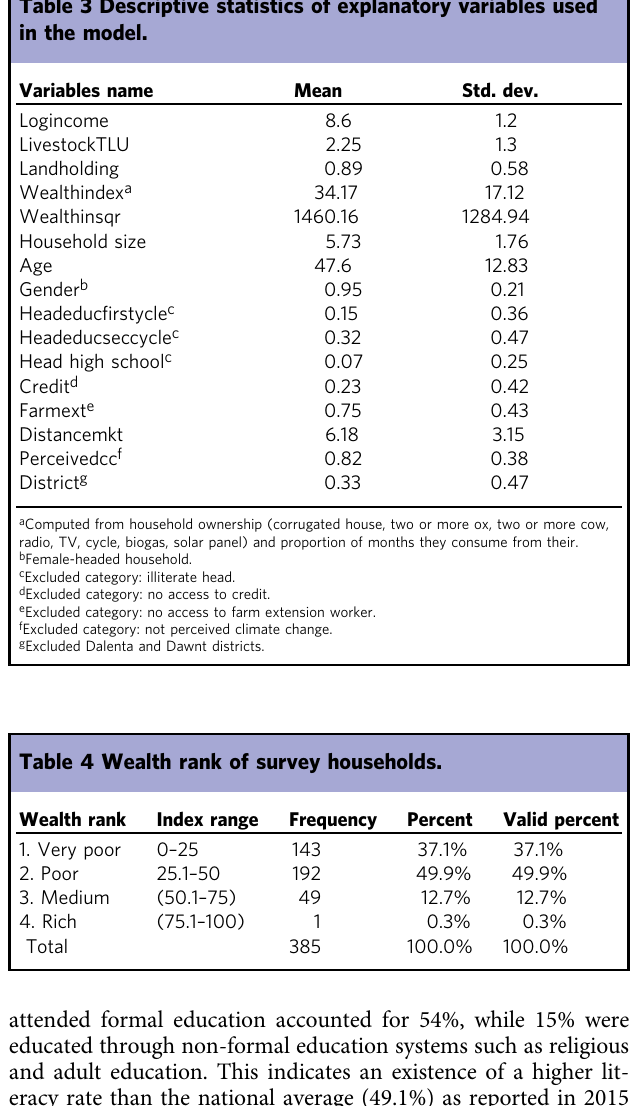
Table 3 Descriptive statistics of explanatory variables used